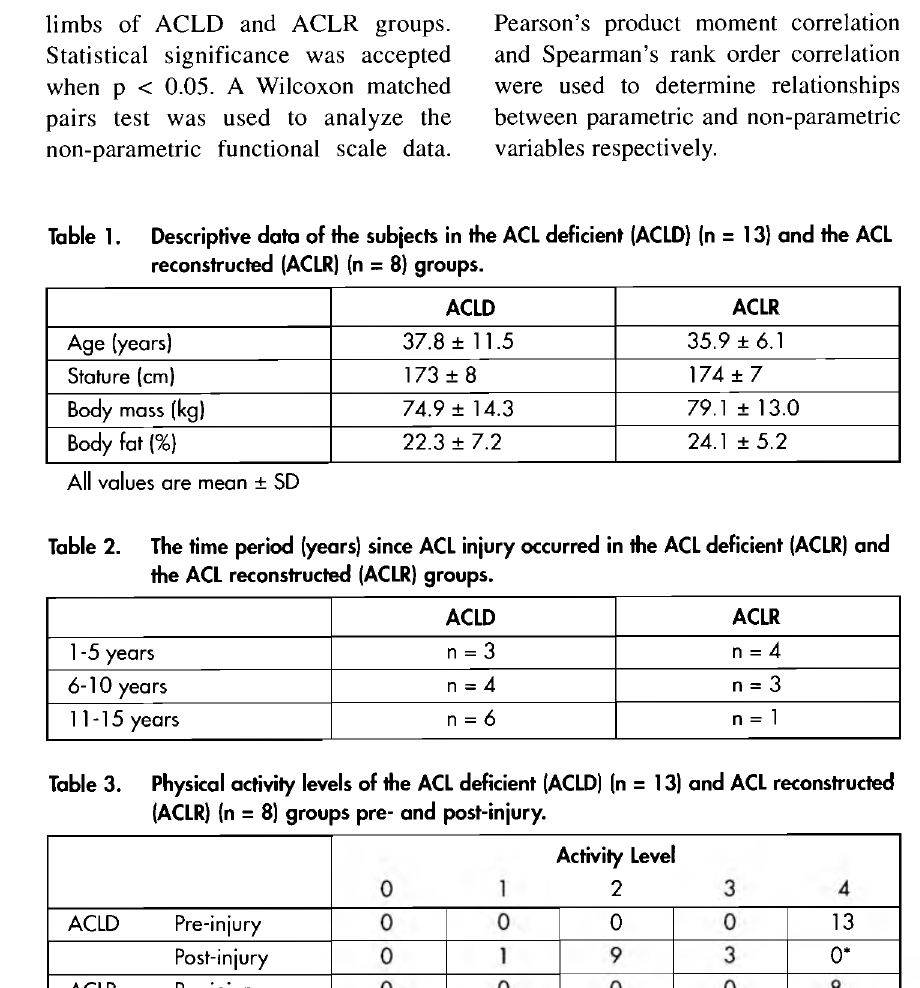
Cincinnati functional score rating for the affected limb of ACL deficient (ACLD) (n = 13) and ACL reconstructed (ACLR) (n = 8)